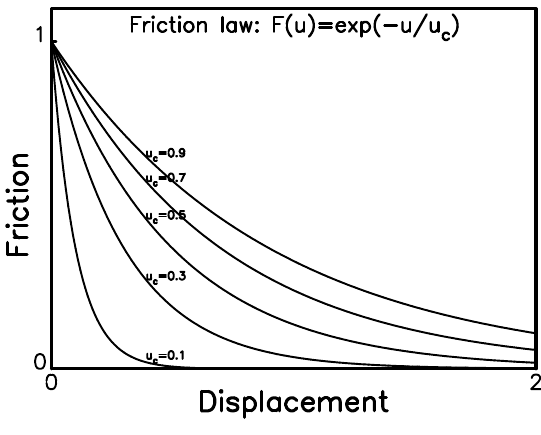
Figure 3. The plots of F(u) = F o exp ( − u/u c ) versus u when u c = 0.1, 0.3, 0.5, 0.7, and 0.9m when F o = 1 N m − 2 (after Wang,